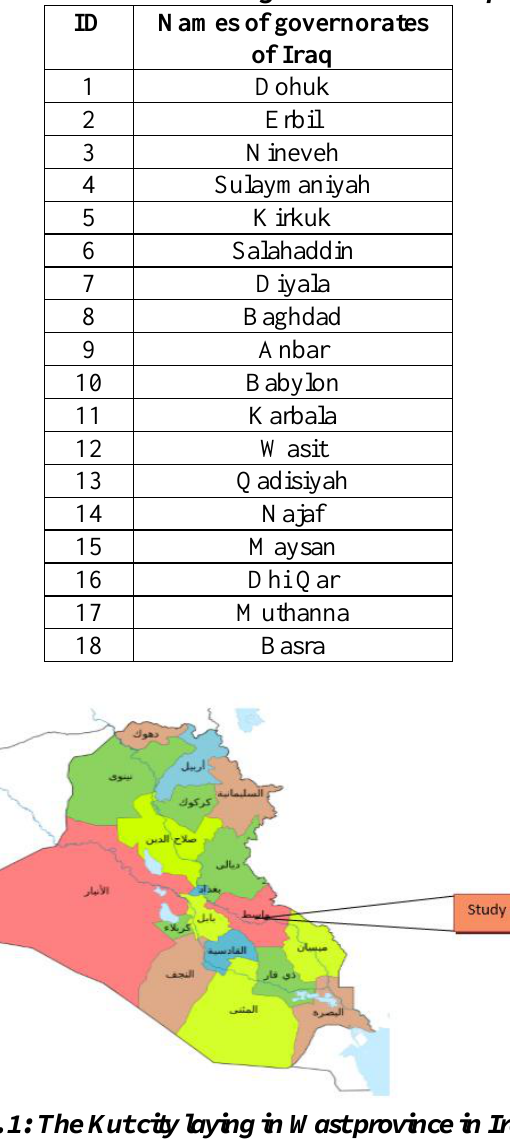
Fig. 4 with Table 1 location of study area. 4- Landsat satellite image in Fig. 5, with Table 2 location of study area.